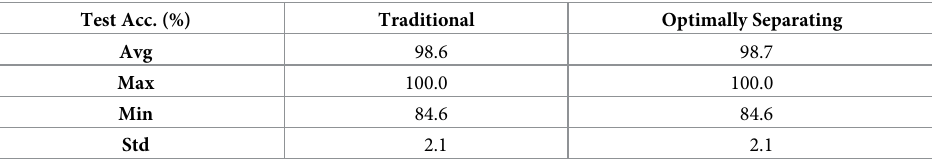
Table 5. Testing-set accuracy comparison between traditional and optimally-separating ANNs. Test Acc.